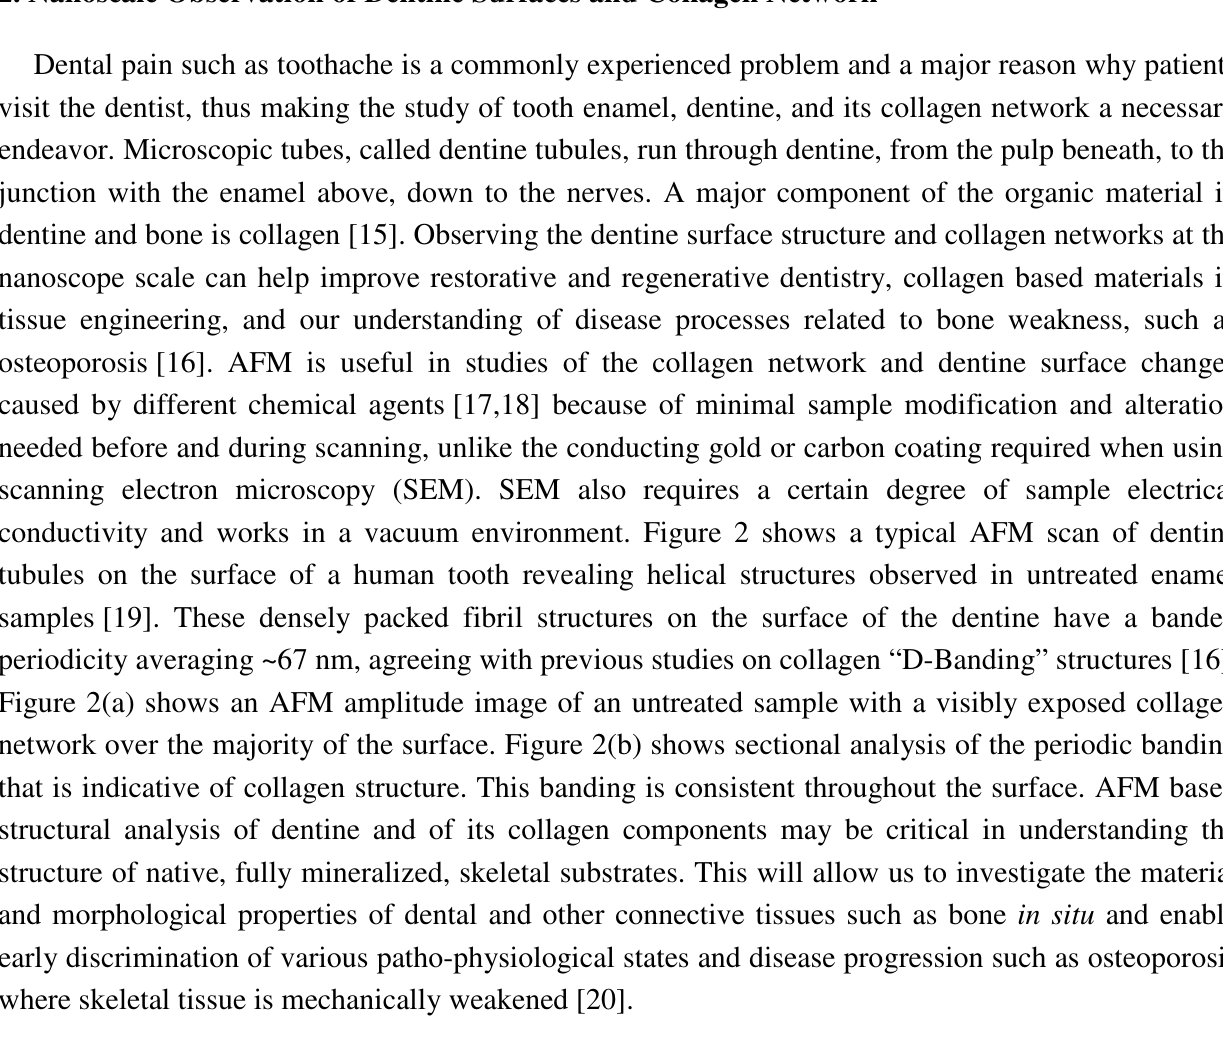
Figure 2. ( a ) Inverted AFM amplitude image of untreated dentine surface with a single open tubule and surrounding exposed collagen network. White box marks periodic banding of ~67 nm indicative of collagen D-banding. ( b ) Sectional profile of the collagen fibril. Reprinted with permission from [19]. Copyright 2009Yes Group,